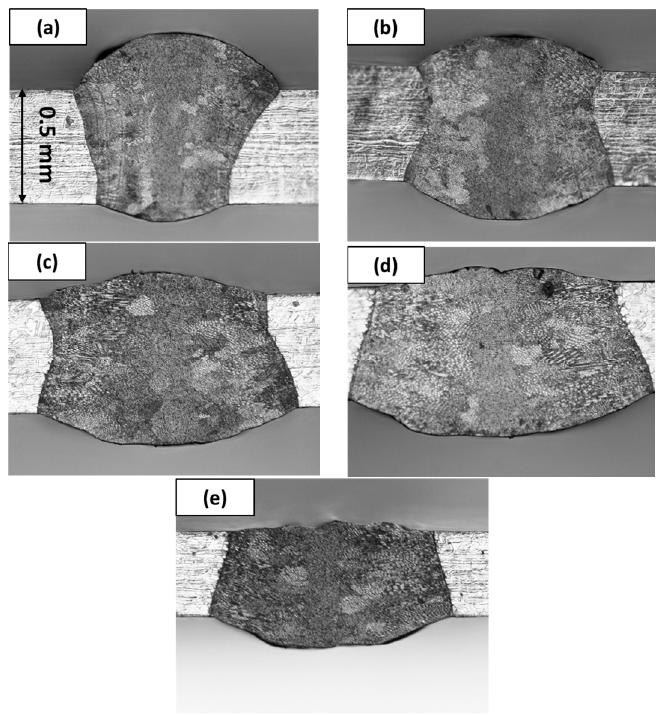
Figure 5. Cross-section of weld bead under different pulse frequency: ( a ) f = 50 Hz; ( b ) f = 60 Hz; ( c ) f = 70 Hz; ( d ) f = 80 Hz; ( e ) f = 90 Hz.